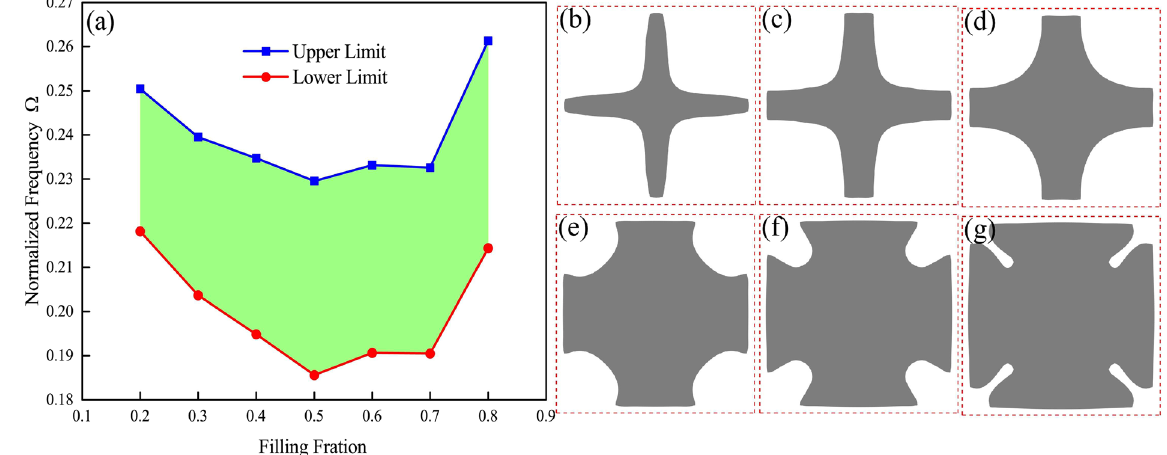
Figure 3. ( a ) Optimized upper and lower limits of AANR frequency range as a function of filling fraction. ( b – g ) Optimized unit cells with filling fraction of 20%, 30%, 40%, 60%, 70% and 80%, respectively.